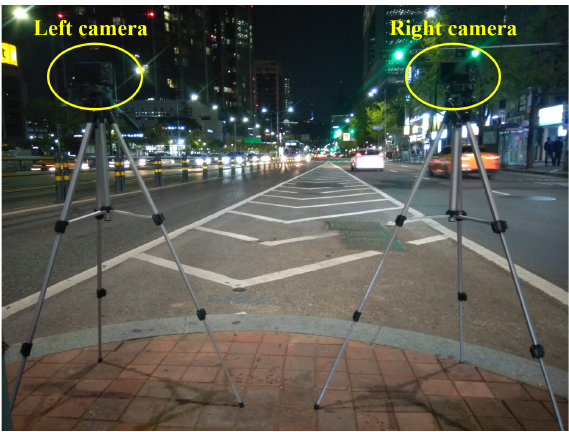
Figure 24. Experimental setup.